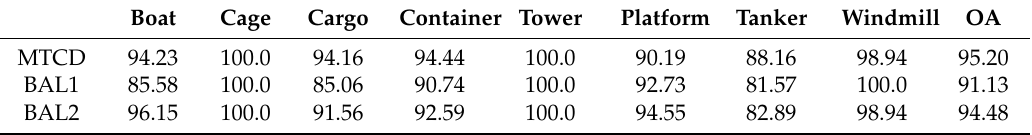
Table 12. Comparison of classification accuracies (%) of MT-CNN trained by MTCD, BAL1, and